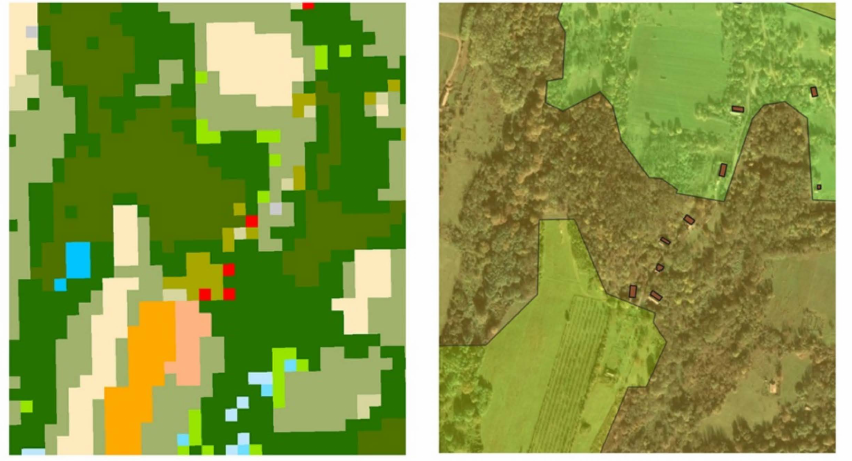
Figure 7. Example of Land use system of Visnyesz é plak with legend (Table 4). Based on Corine, Ecosystem Map of Hungary and Google Satellite